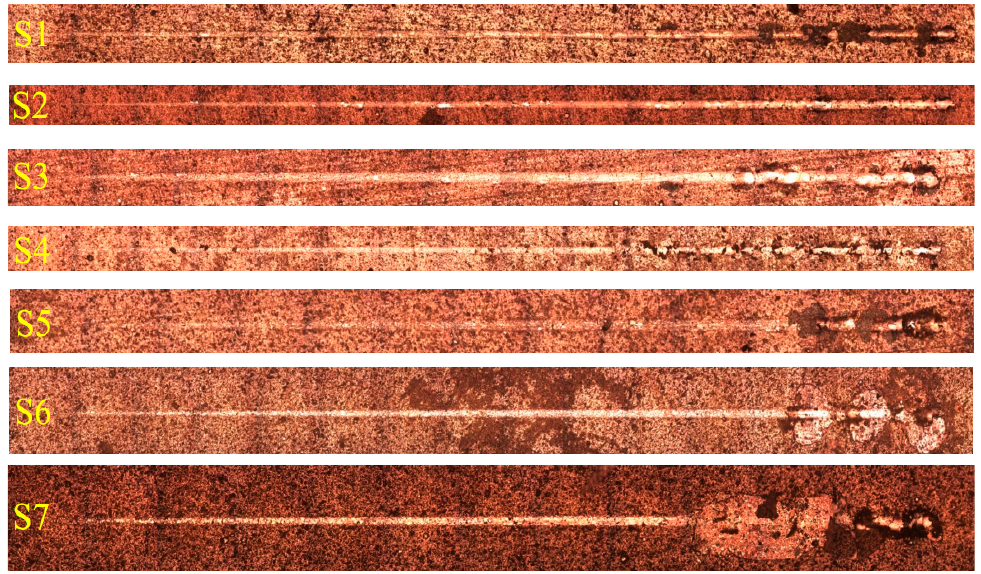
Figure 13. Scratch tests of the coatings under study.